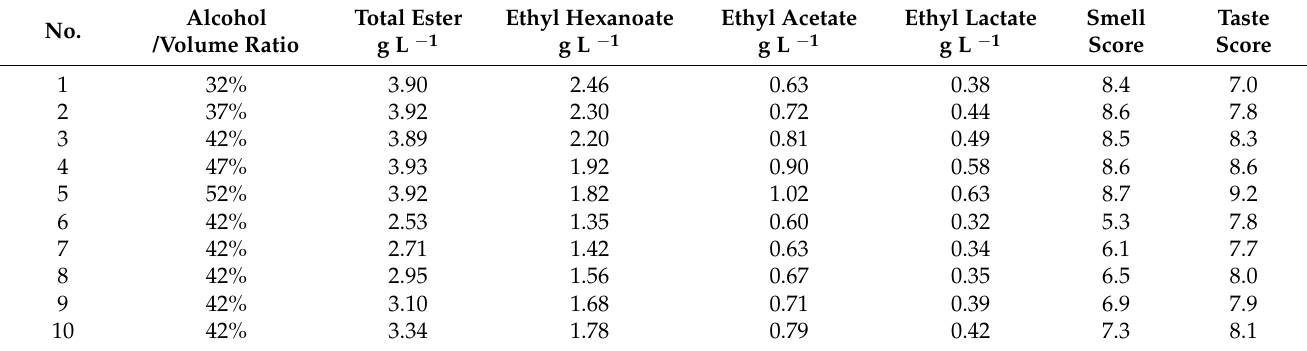
Table 2. Sensory evaluation of model Baijiu with different alcohol and ester